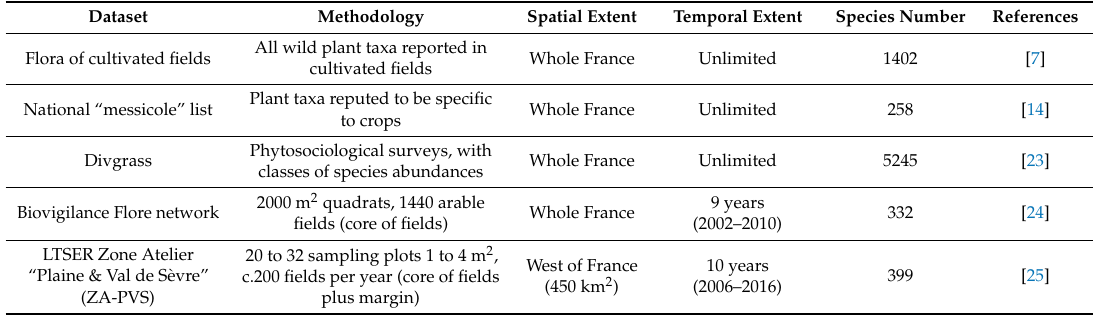
Table 1. Datasets considered in the present study, with corresponding methodological information, spatial and temporal extents, and species